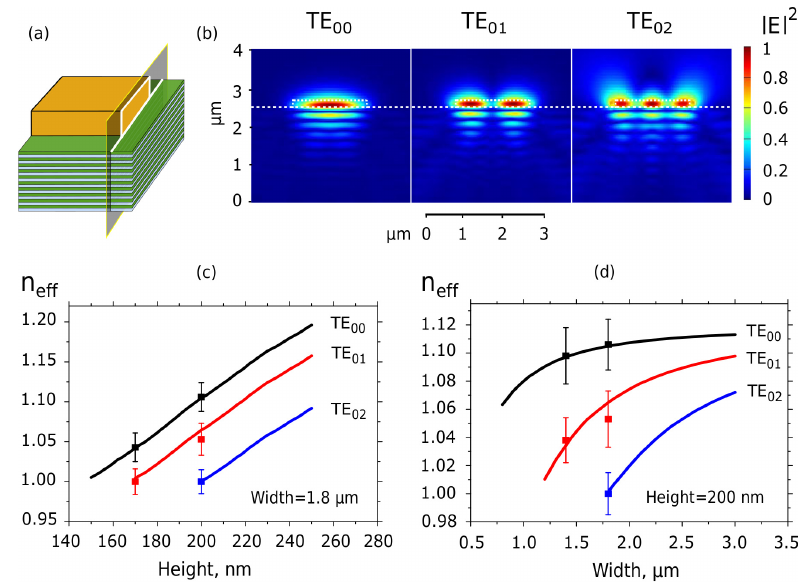
Figure 6. ( a ) A schematic view of a model waveguide with a marked cross-section; ( b ) Electric field distribution in a waveguide cross-section for different modes, sustained by a model waveguide, whose size corresponds to sample 1; ( c ) The dependence of effective refractive index on waveguide height for different modes. The width of the waveguide is 1400 nm. Experiment—dots, theory—solid lines; ( d ) The dependence of effective refractive index on waveguide width for different modes. The height of the waveguide is 200 nm. Experiment—dots, theory—solid